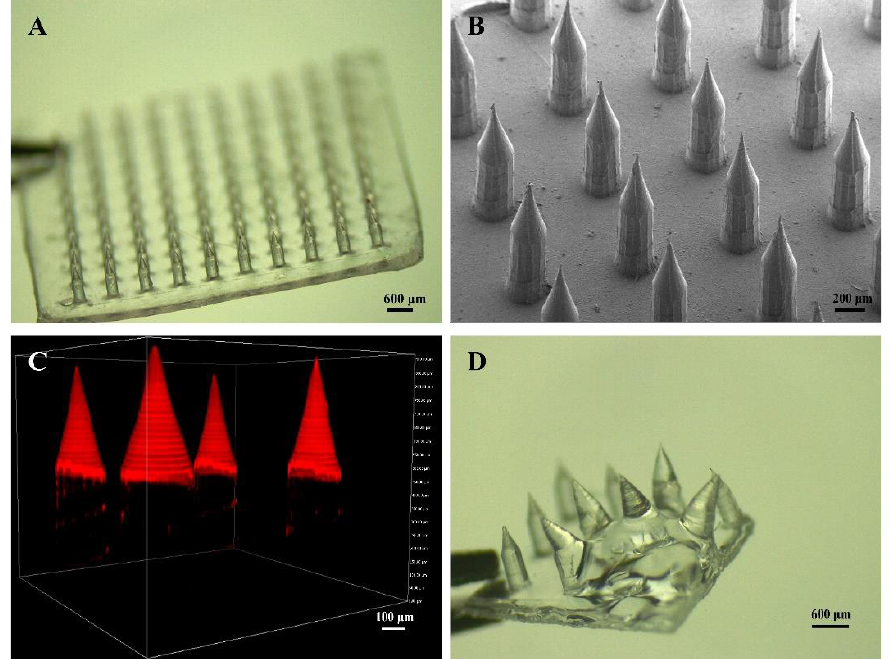
Figure 2. Characterization of the separable MN. ( A ) Optical image. ( B ) SEM image. ( C ) 3D image of the separable MN prepared by EFL-DYE-UF-ENE-R labeled mHA. ( D ) Optical image of the separable MN after water rinsing.